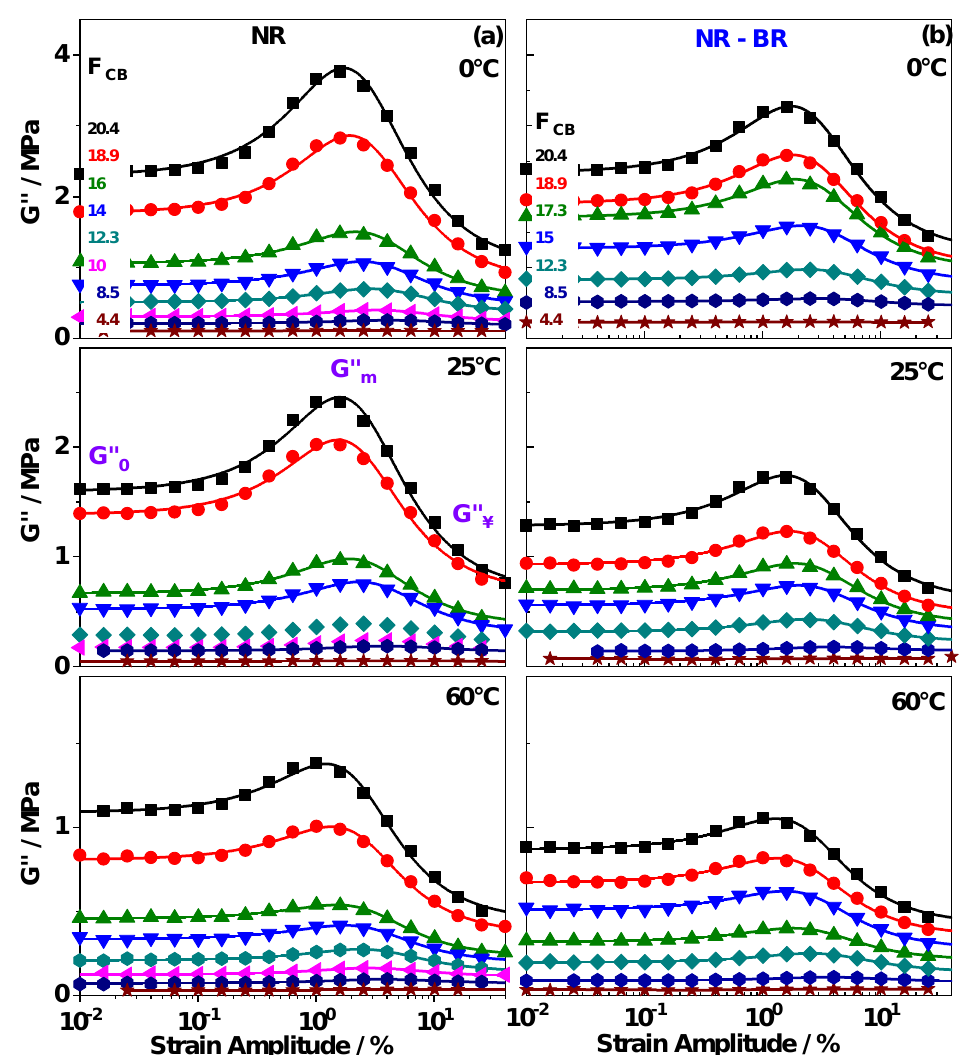
Figure 3. Dynamic loss modulus G (cid:48)(cid:48) as a function of shear strain amplitude γ for ( a ) NR and ( b ) NR-BR composites with varied fraction of carbon black Φ CB (Volume fractions are labeled in the upper plot). All measurements are done at 10 rad/s and temperatures of 0 ◦ C, 25 ◦ C and 60 ◦ C. The lines over the data points are fits based on the modified Kraus Equation (Equation (2)). The values obtained for ∆ G (cid:48)(cid:48) and ∆ G (cid:48)(cid:48) are given in Table 1. Experimental uncertainties of the mechanical D F measurements are of the order of symbol